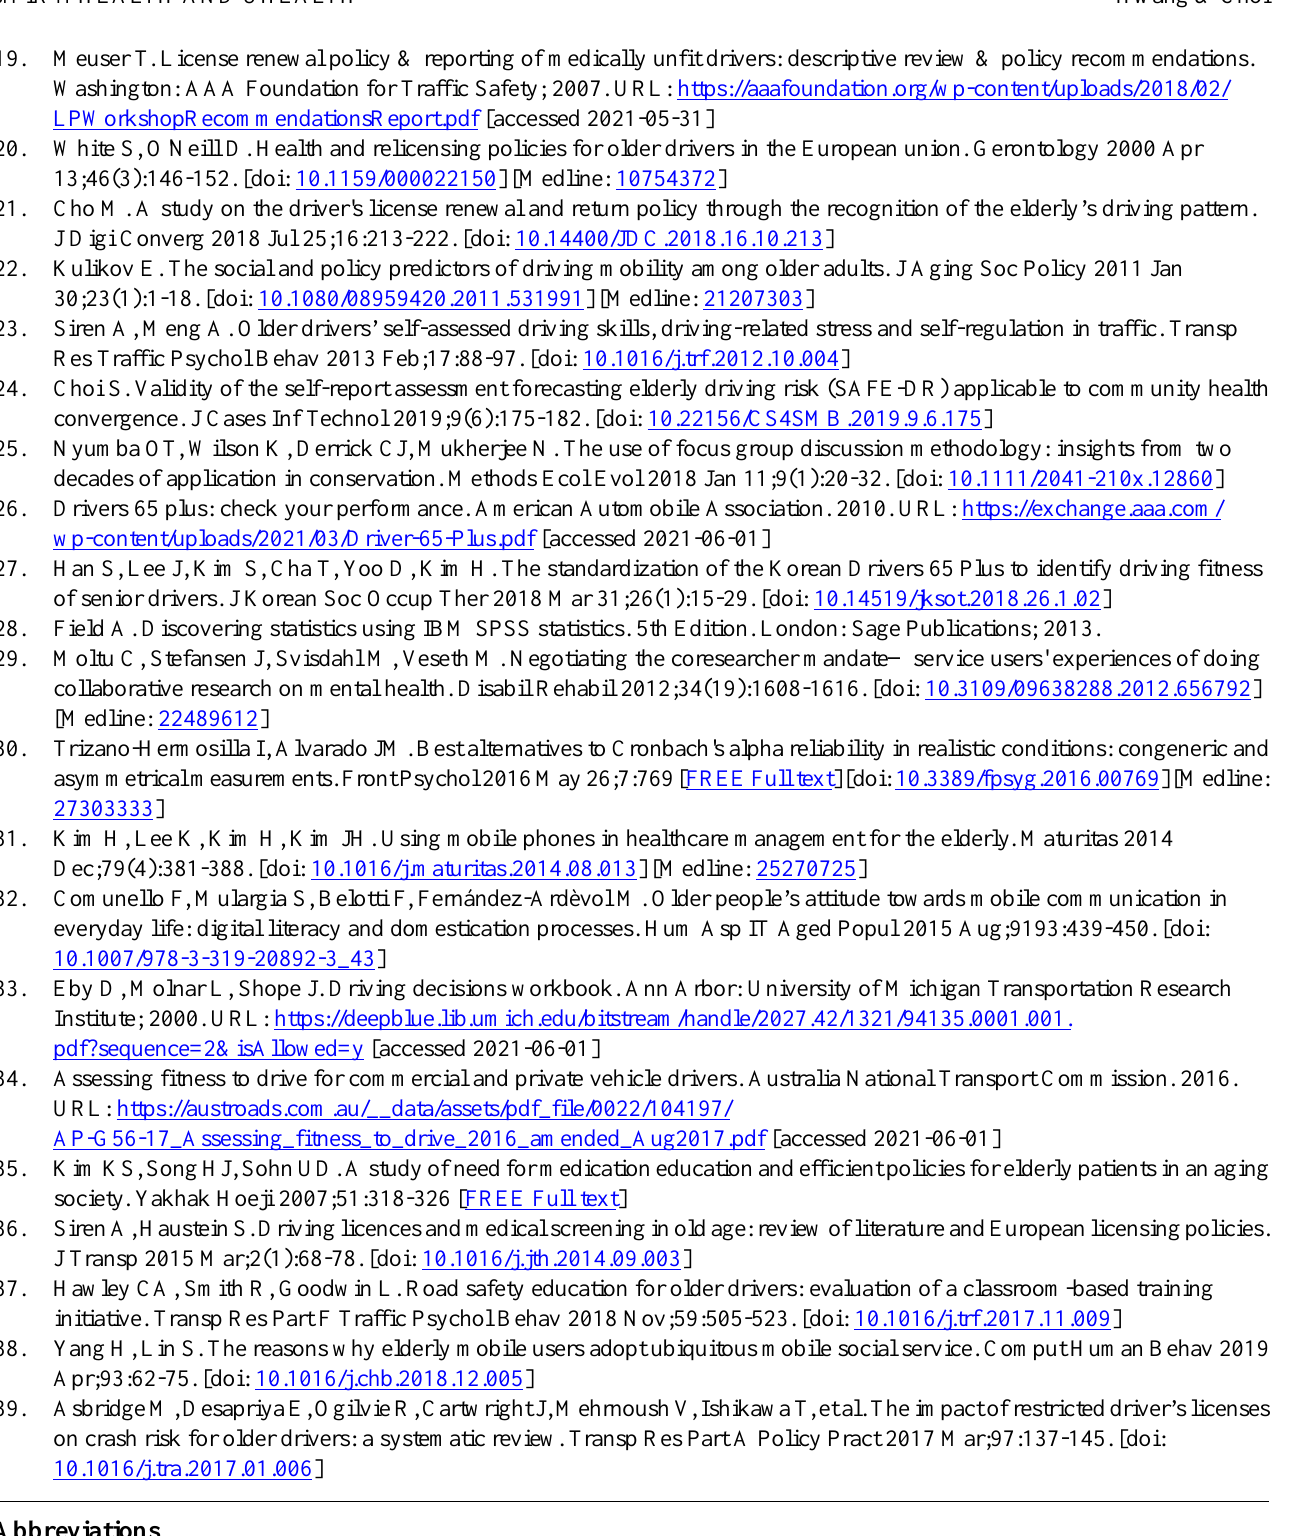
SAFE-DR: Self-Report Assessment for Elderly Driving